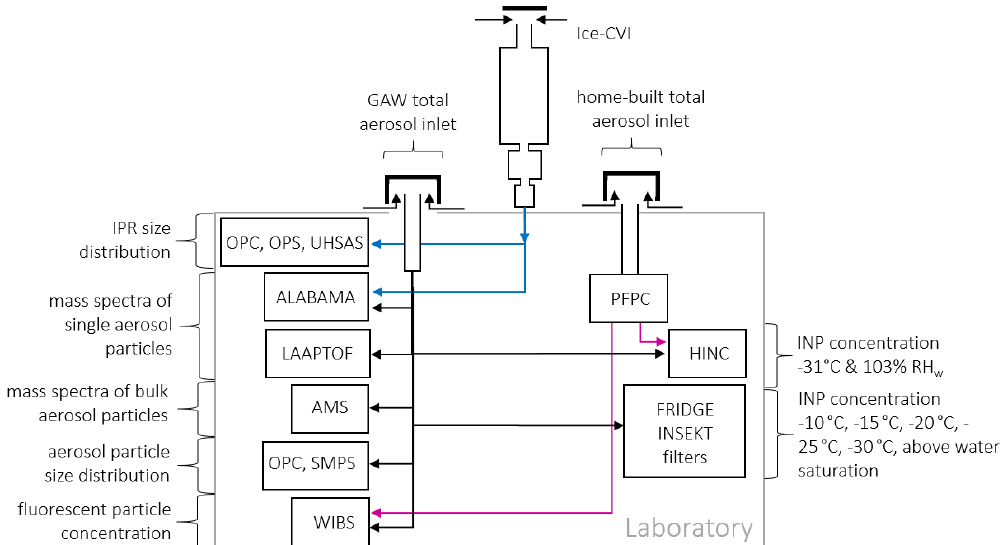
Figure 1. Setup of instruments at the Sphinx observatory at JFJ. The instruments were mostly sampling via the GAW total aerosol inlet (black line). The aerosol particle chemical composition was measured with ALABAMA, the LAAPTOF, and an AMS; aerosol particle size was detected using an OPC and a SMPS; fluorescent biological particles were measured with a WIBS; online INP concentrations were measured with HINC and offline with INSEKT and FRIDGE. HINC and WIBS measurements were alternated at the GAW and a home-built total aerosol inlet (black line) connected to the portable fine particle concentrator (magenta line). Measurements of IPR were performed at the Ice-CVI inlet (blue line) for IPR size (using an OPC, OPS, and UHSAS) and for chemical composition (using